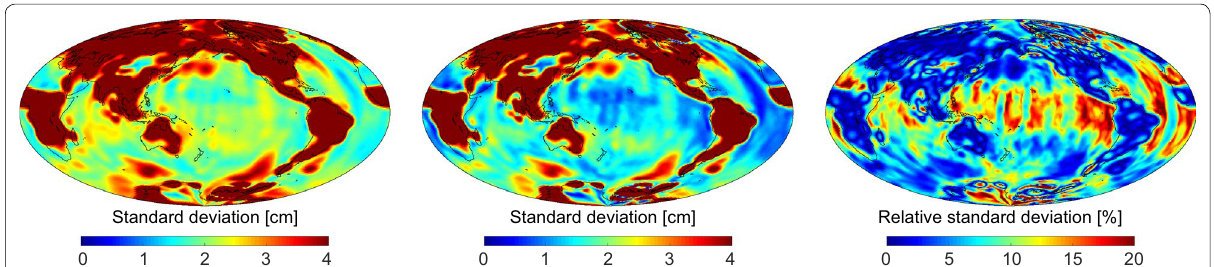
Fig. 7 Standard deviation of equivalent water heights over 13 years (2003–2015) derived from GRACE GFZ RL06 gravity field solutions using only the DDK filter (left) and by applying the DDK filter and the filter effect reduction approach (middle). Furthermore the relative standard deviations of the corresponding equivalent water height residuals are shown (right)